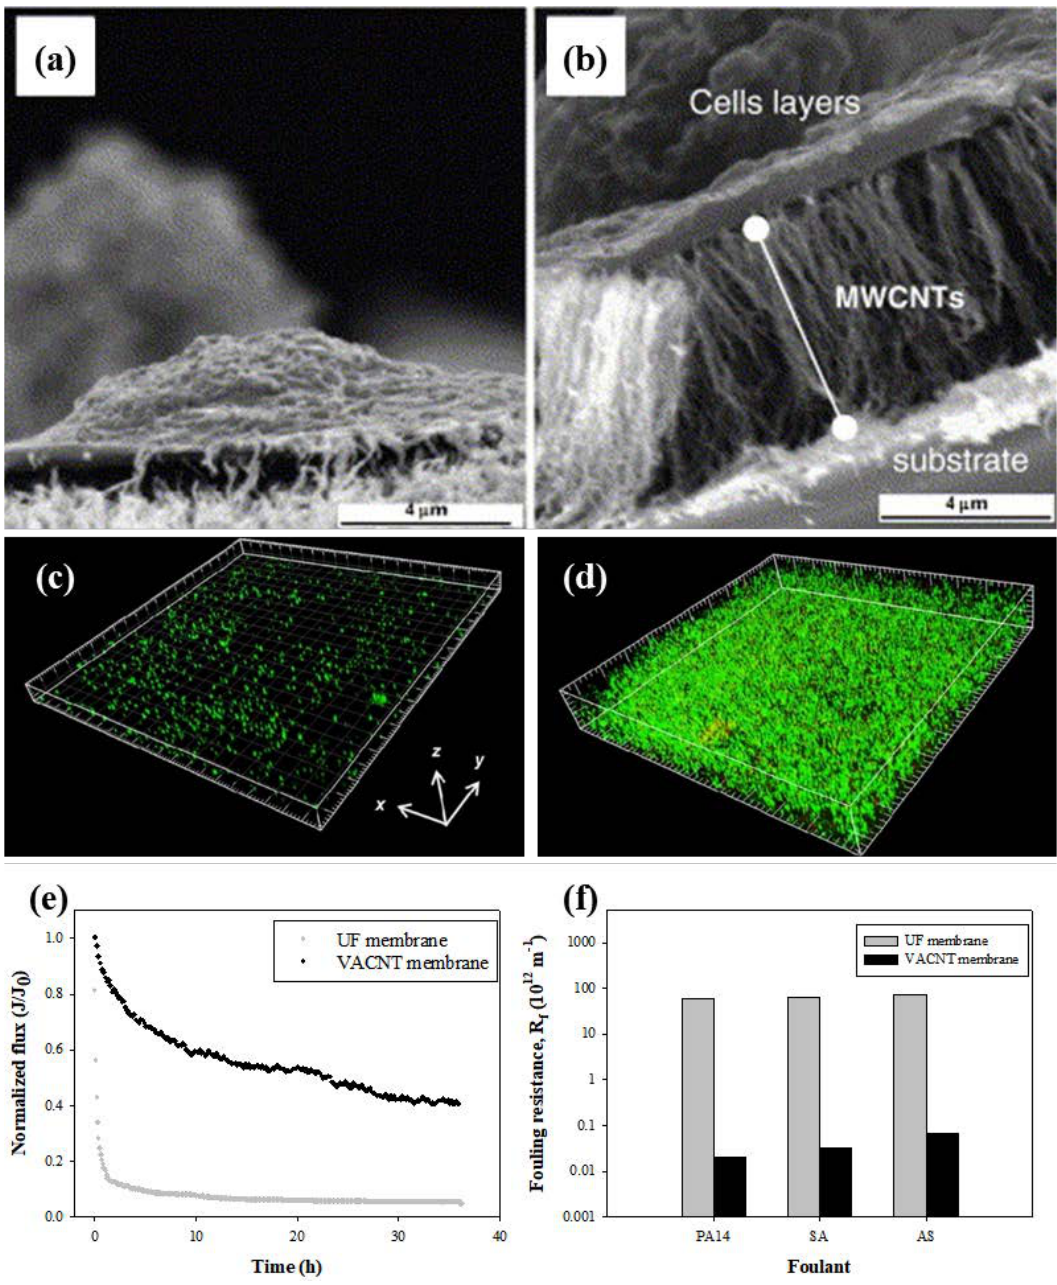
Figure 7. Antibacterial activities of vertically aligned carbon nanotube (VACNT) membranes. Scanning electron microscope (SEM) images of interaction between the L929 fibroblasts cells and the aligned multi-wall carbon nanotube (MWCNT) ( a ) after 48 h of incubation and ( b ) after 7 days of incubation [105]. Confocal laser scanning microscopy (CLSM) images after biofouling occurrence for 600 min on the ( c ) VACNT membrane and ( d ) UF membrane (green: live cells, red: dead cells) [17]. ( e ) Flux (J / J 0 ) declines over time for the VACNT membrane and the ultrafiltration (UF) membrane operated with the feed solutions of activated sludge. ( f ) Fouling resistance (R f ) of the UF and VACNT membranes fouled by Pseudomonas aeruginosa (PA14), Staphylococcus aureus (SA) and activated sludge (AS) solution [104] .